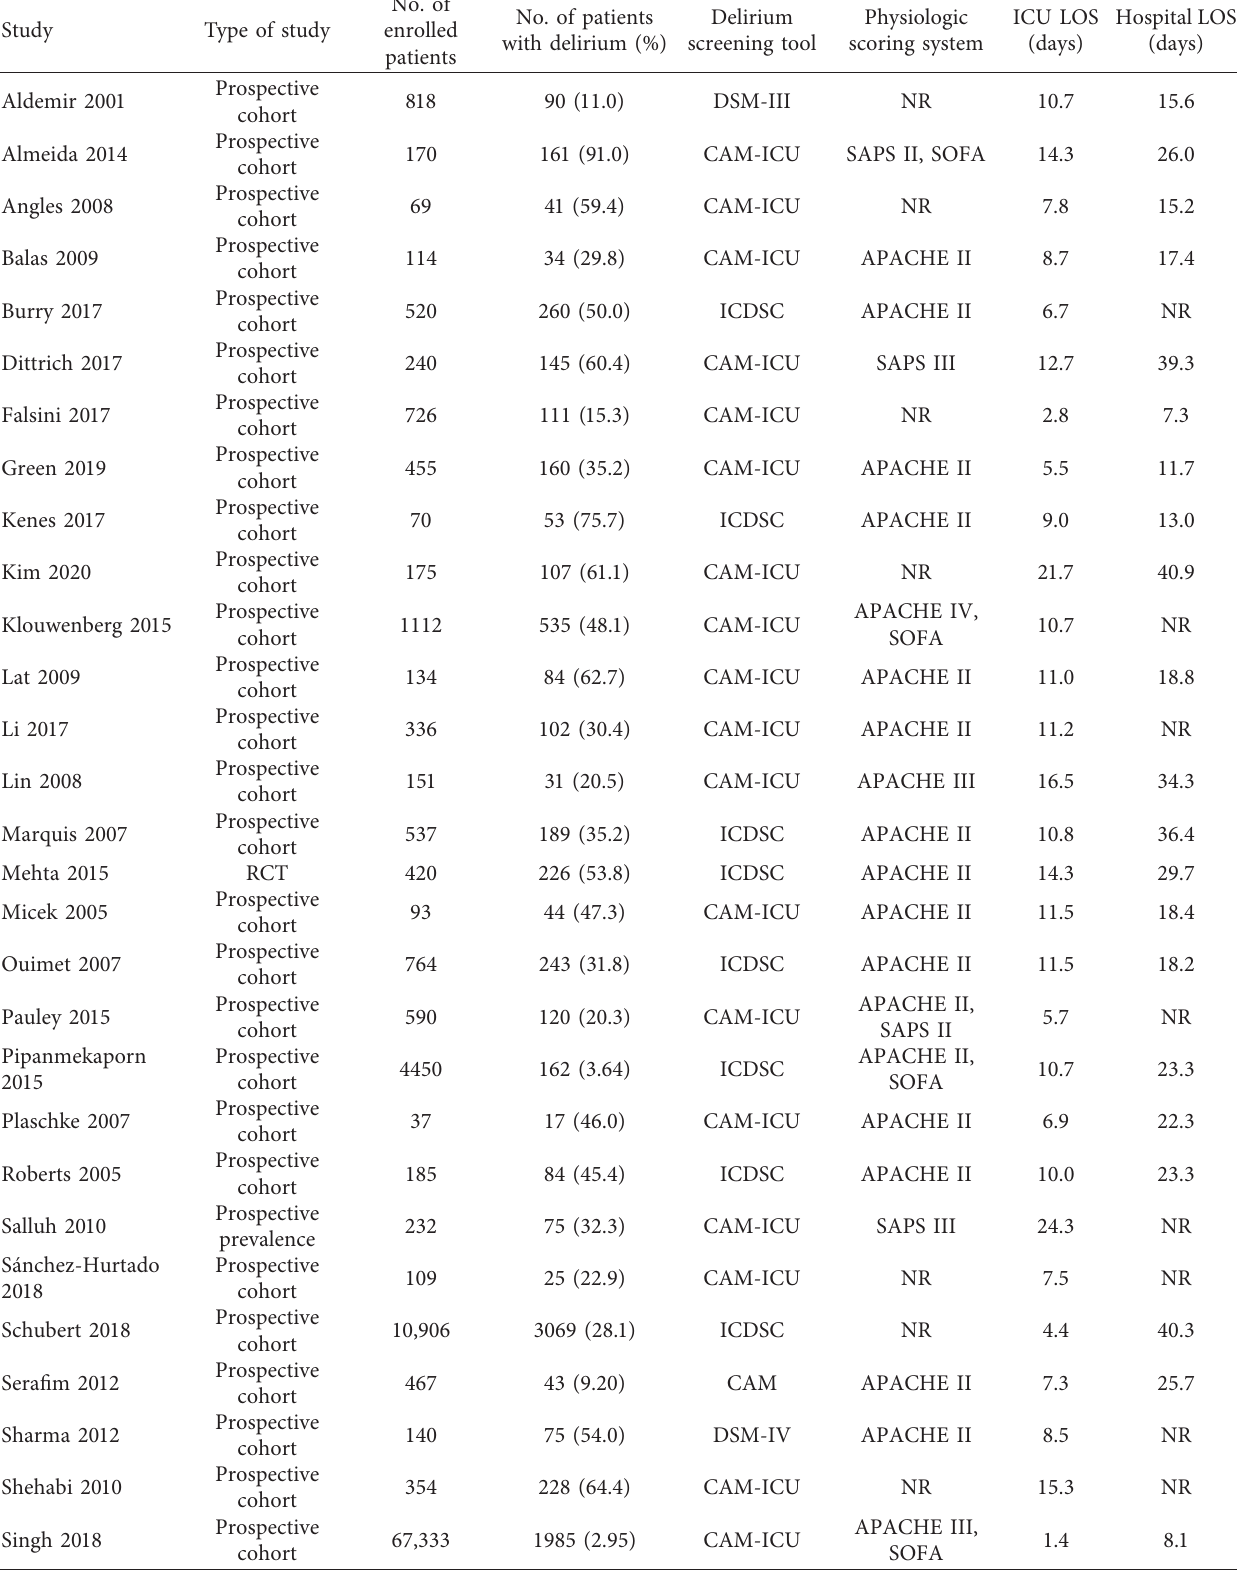
Table 1: Demographics and delirium screening tools of the included